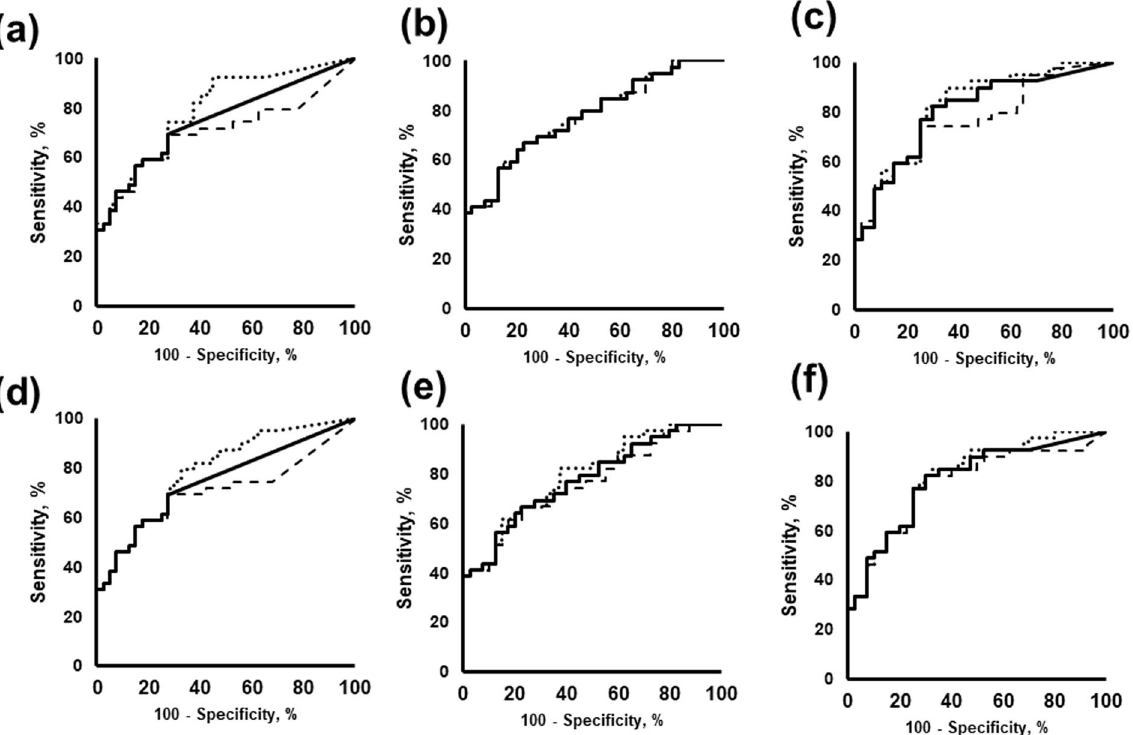
Figure 6. ROC curves of salivary metabolites in discriminating pancreatic cancer (n = 40) from control and chronic pancreatitis (n = 39). ( a ) N 1 -acetylspermine, ( b ) N 1 -acetylspermidine, and ( c ) spermine in short-term storage test. ( d ) N random noise. In total, 200 curves were generated with random values. ROC curves showing the top 2.5% and 97.5% AUC values are